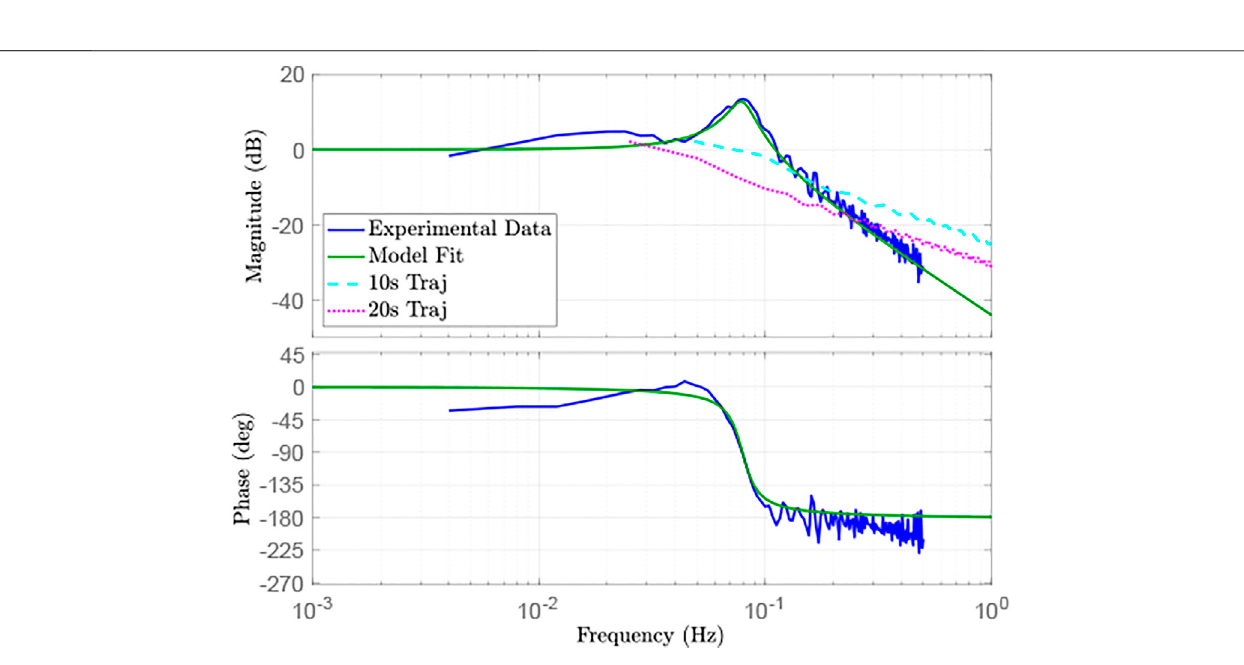
Frontiers in Robotics and AI |